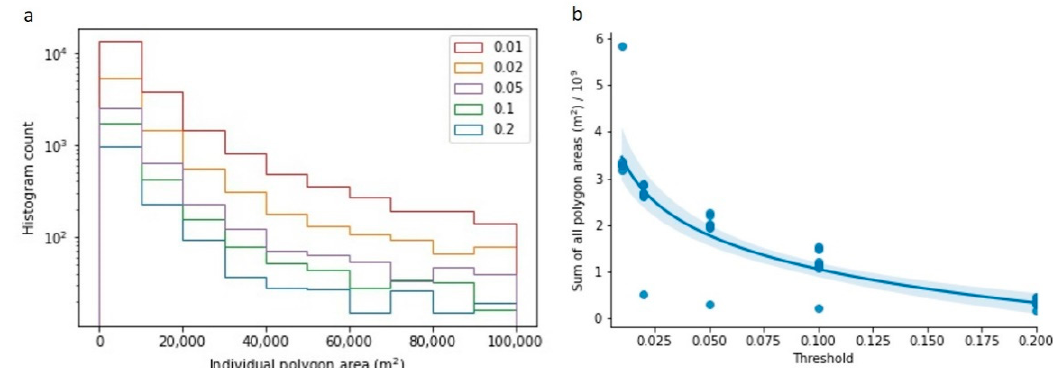
Figure A1. Wet frequency threshold impacts on ( a ) the total number of individual mapped waterbodies, ( b ) the total area contained within the individual mapped waterbodies. Individual scatter points represent integrations over different time periods from 1987 to 2018.